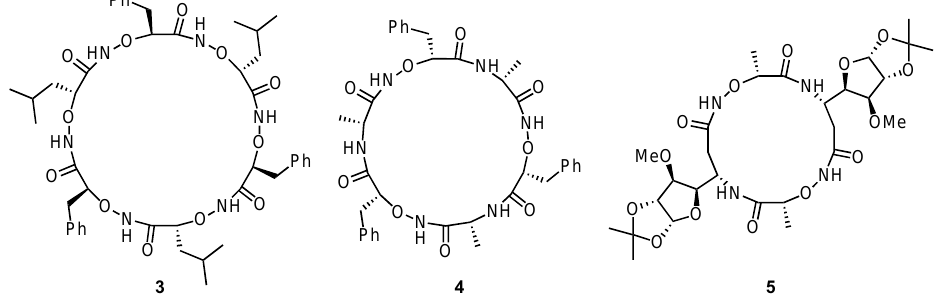
Scheme 2. Structures of the cyclic pseudopeptides 3 , 4 , and 5 containing α -aminoxy acid subunits.